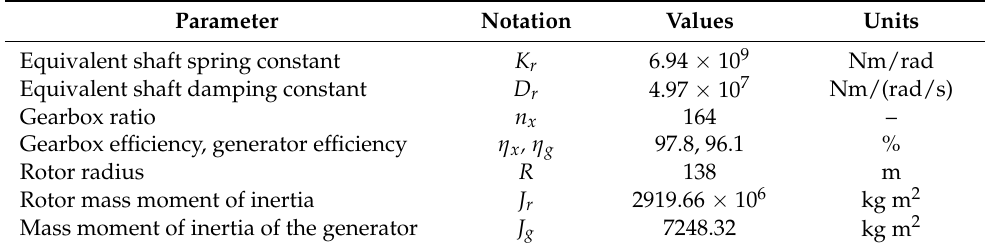
Table 1. Essential parameters of the 20 MW reference wind